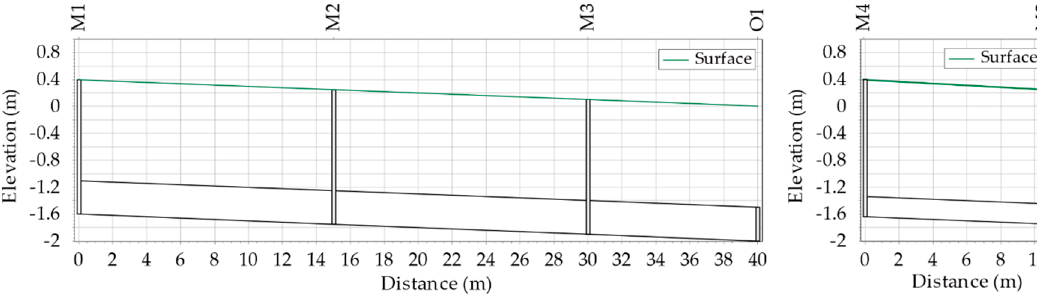
Figure 3. Longitudinal profile of the drainage network.